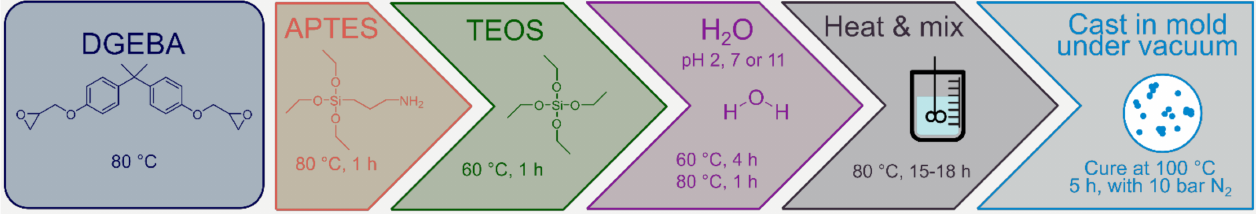
Scheme 1. An outline of the sol–gel procedure used in the in situ synthesis of SiO 2 functionalized with APTES in